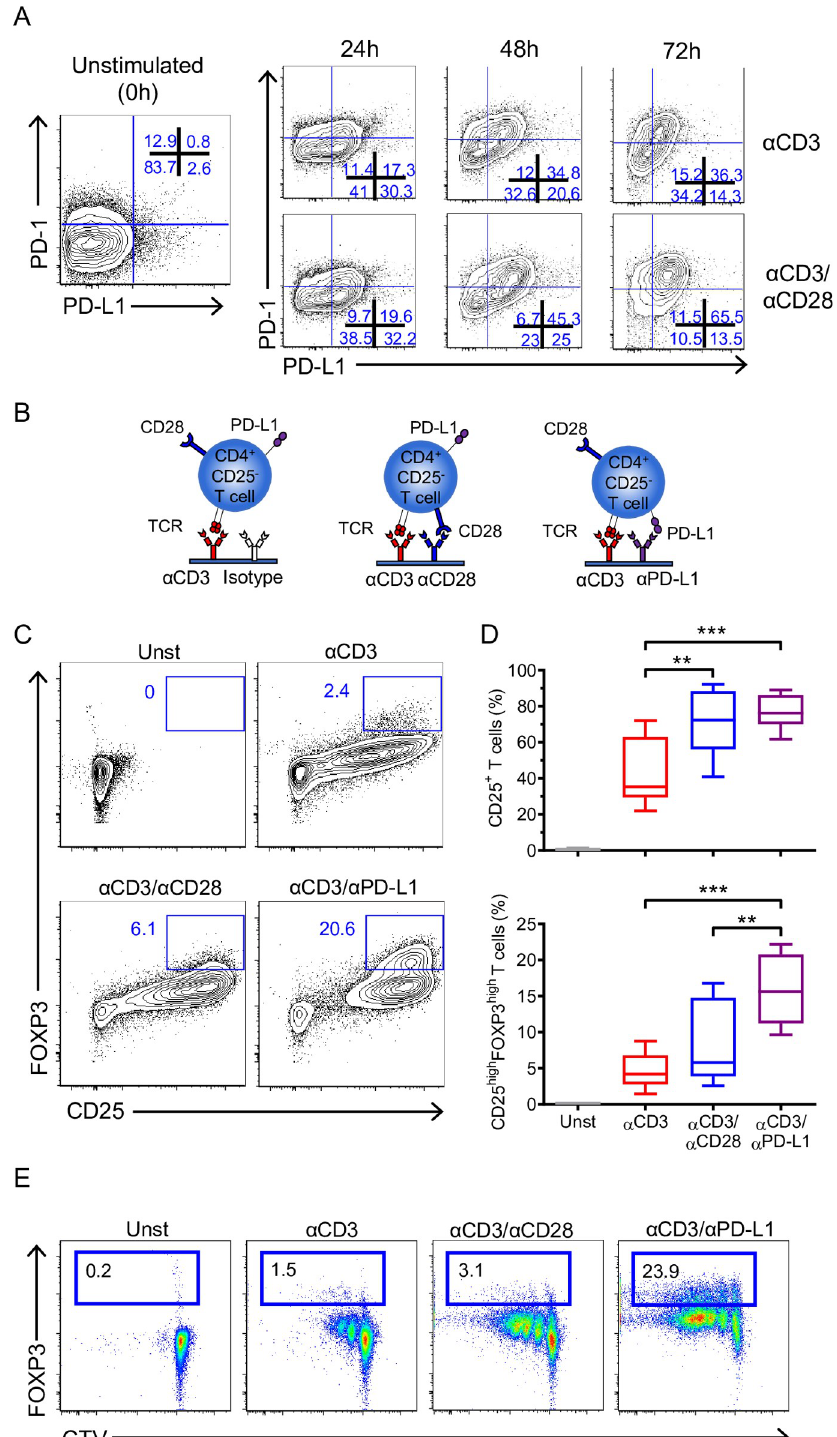
Fig 1. PD-L1 cross-linking on CD4 + CD25 − T cells promotes their activation and proliferation. ( A ) Representative dot plots showing the expression of PD-1 and PD-L1 on freshly isolated CD4 + CD25 − T cells (left panel) and upon stimulation with α CD3 or α CD3/ α CD28 at different time points (24, 48, and 72 h) (right panel). ( B ) Schematic representation of different activation conditions used in our model. CD4 + CD25 − T cells were stimulated as indicated in ( B ) for 72 h, and ( C ) the expression of CD25 and FOXP3 was analyzed and ( D ) quantified ( n = 8 from